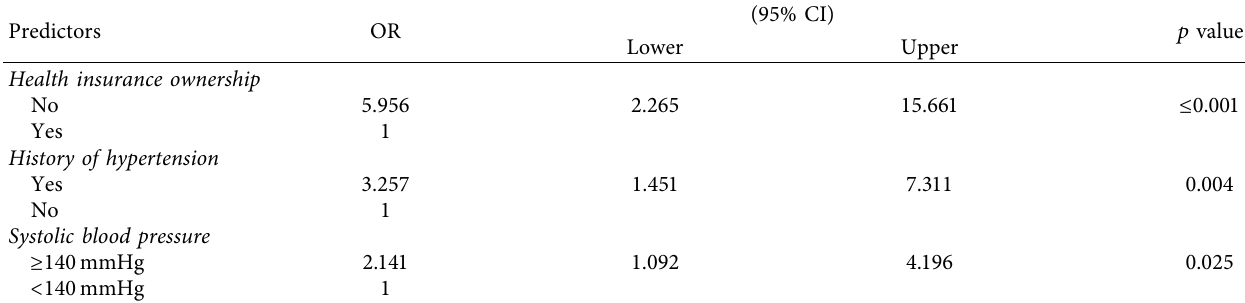
Table 4: Final multivariate logistic regression model of risk factors for